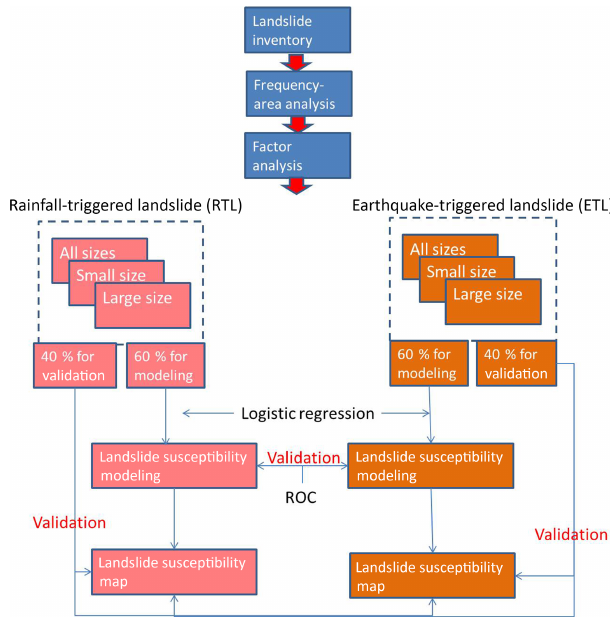
Figure 3. Methodology for susceptibility assessment of different types and sizes of